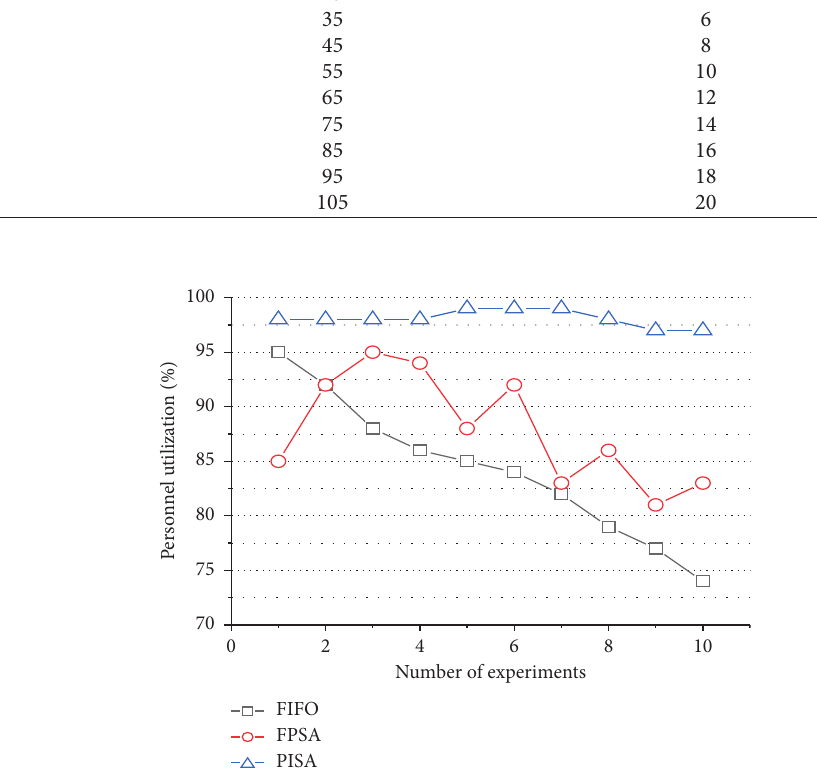
Figure 7: Comparison of personnel utilization of different